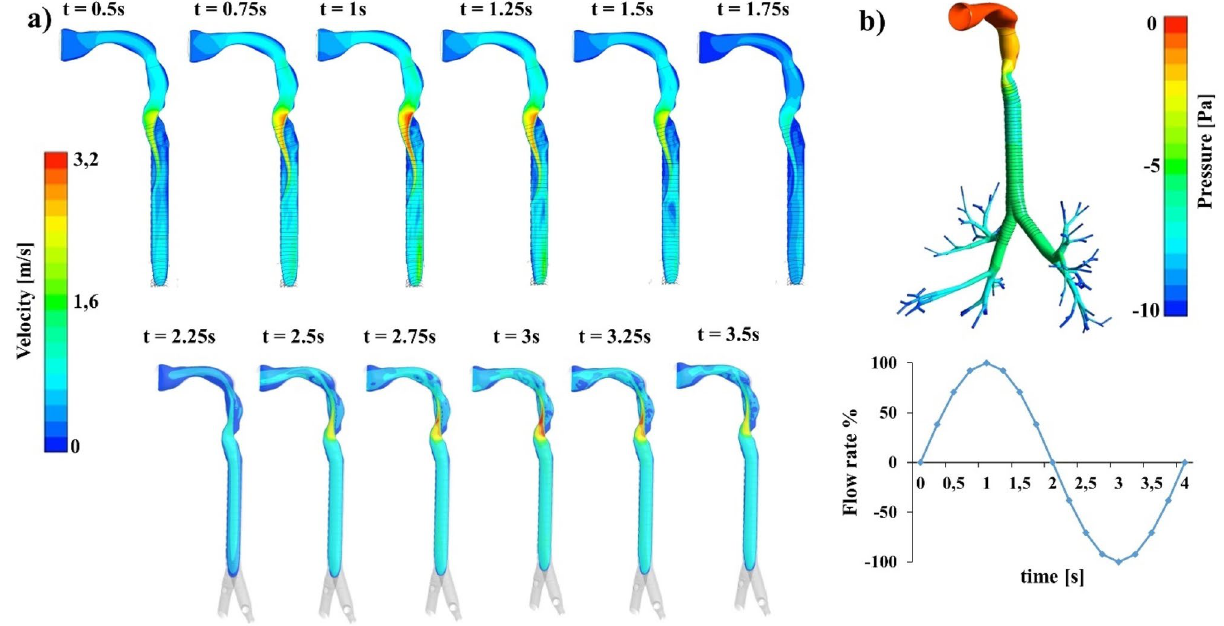
Figure 1. Airflow pattern and pressure trend during sedentary breathing cycle ( a ) Magnitude of velocity on the longitudinal plane. In evidence the acceleration across the larynx constriction. ( b ) Static pressure field along the respiratory system at the inspiration peak (t = 1 s). (Fluent v16, CFD-Post v16-Ansys, www.ansys .com).